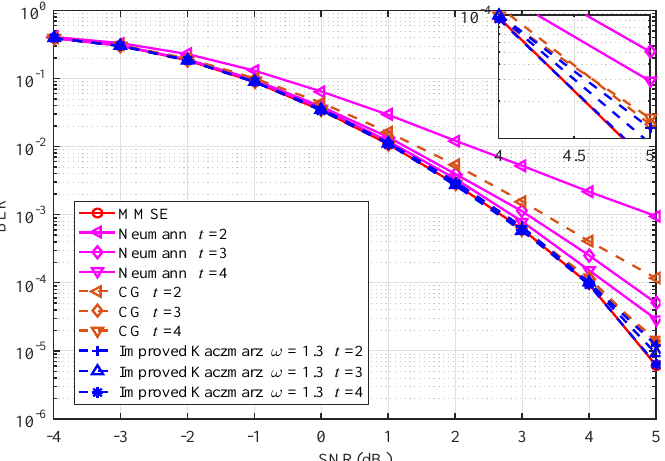
Figure 4. BER performance comparison (128 × 16).